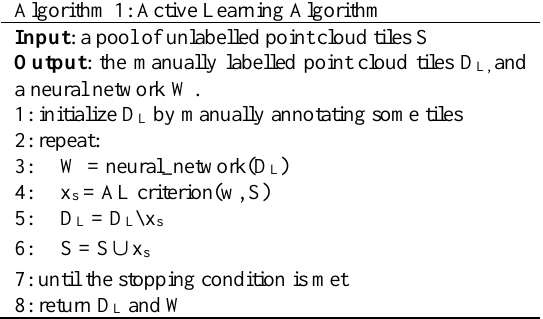
Algorithm 1: Active Learning